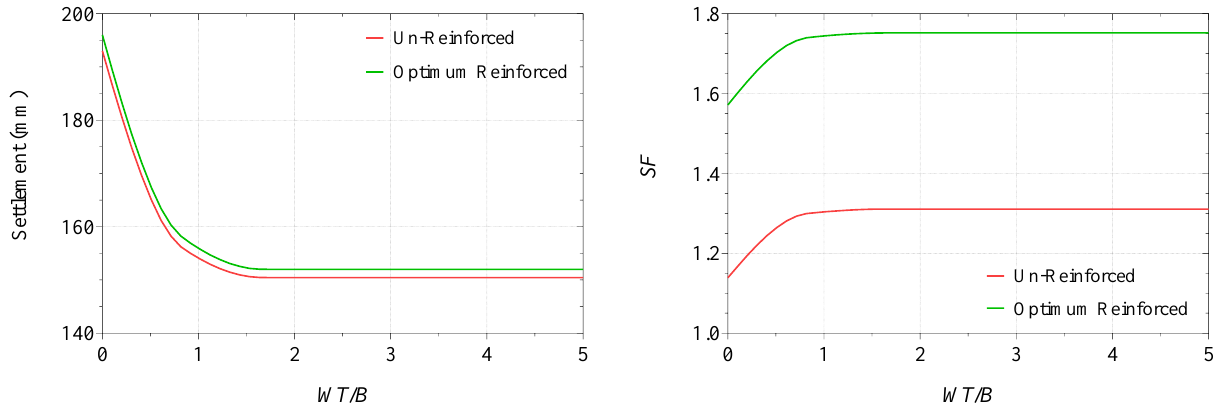
Figure 9. Comparison of the settlement and the safety factor of the soil-footing system in various WT/B for the optimum reinforcement